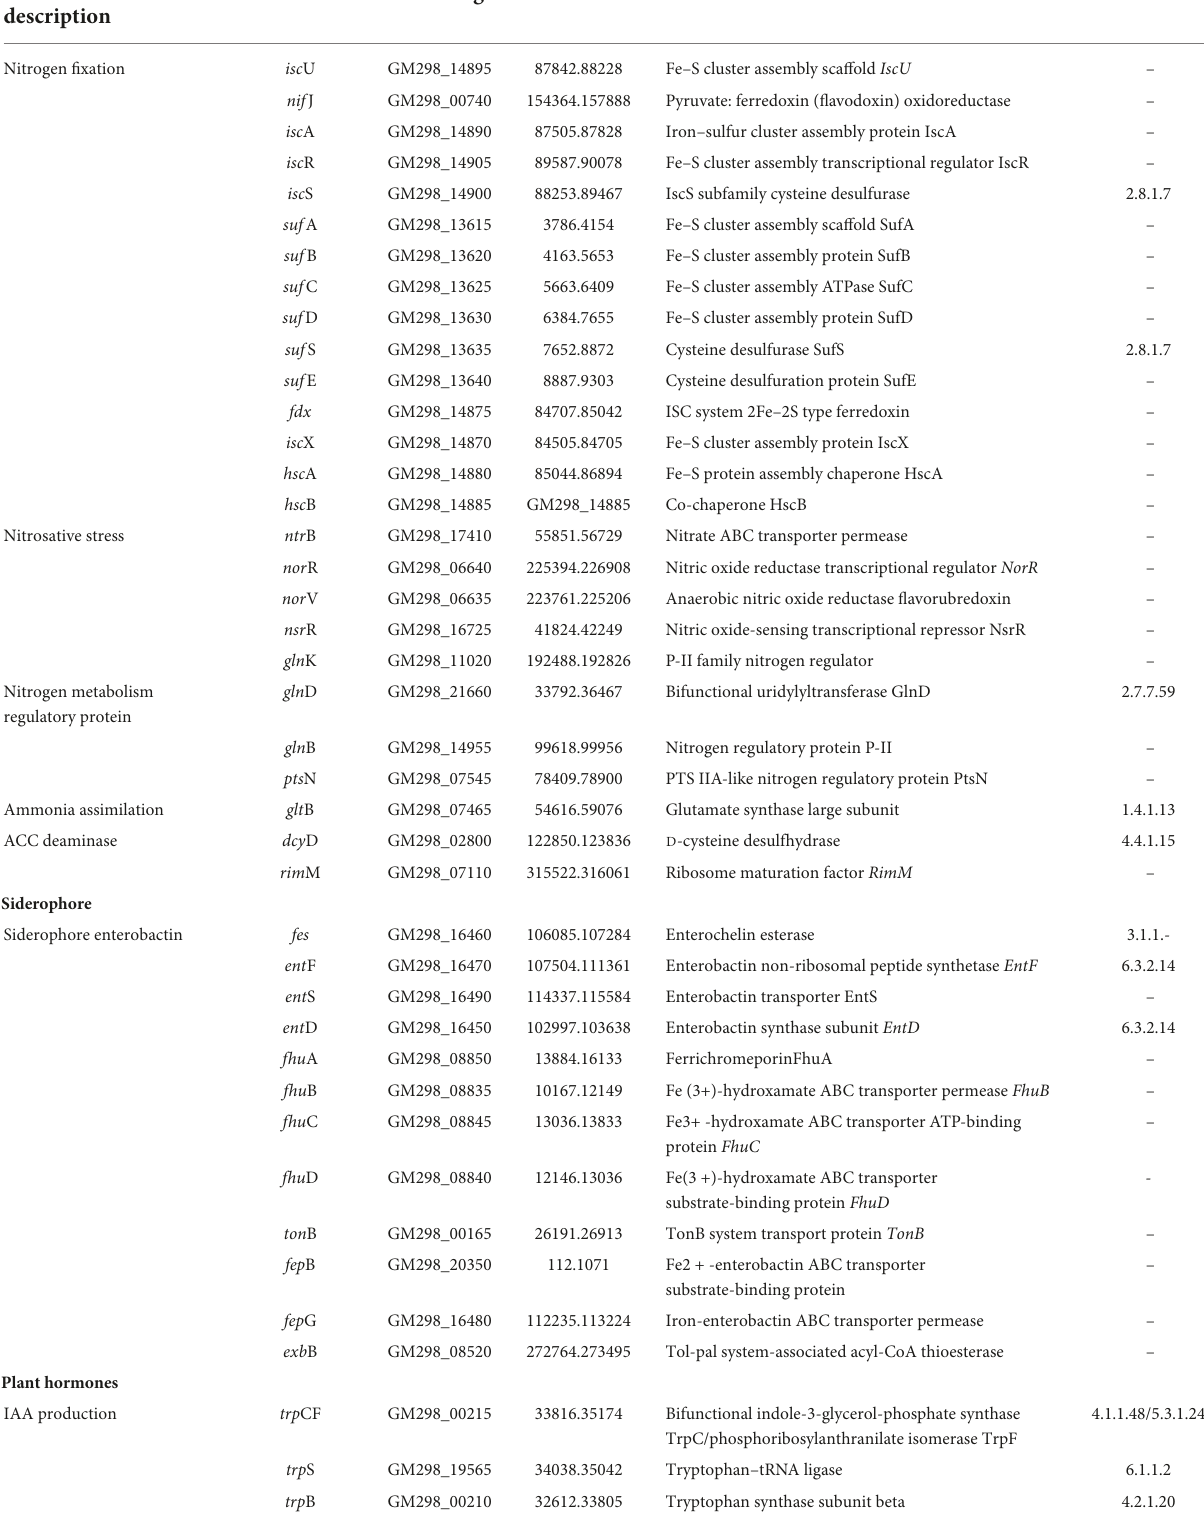
TABLE 5 Genes involved in plant growth promoting, stress tolerating, and pesticide degrading